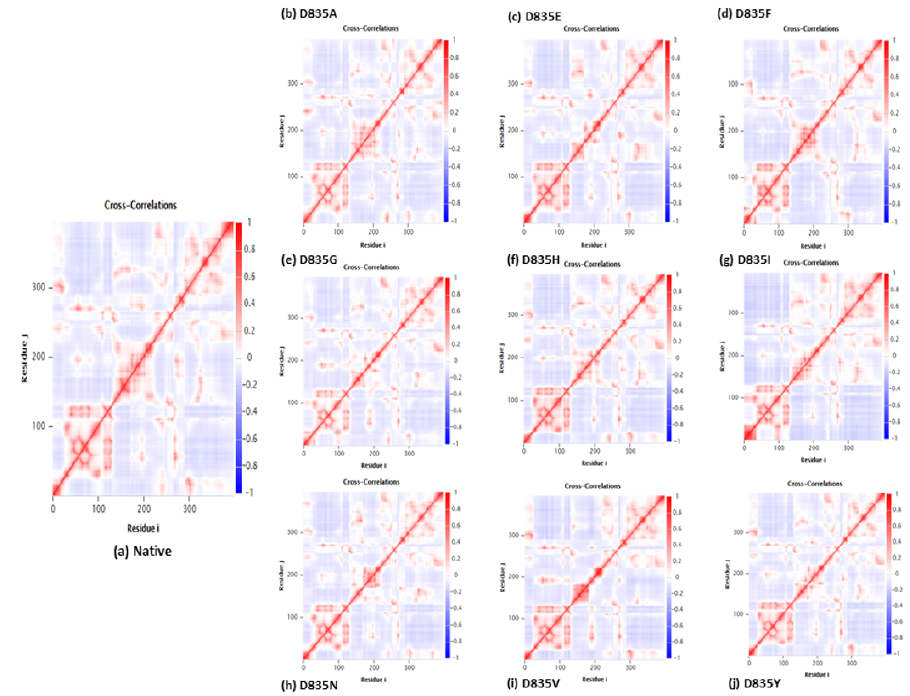
Figure 7. Native and mutant FLT3 proteins cross-correlation matrix of the fluctuations of coordinates for C α atoms around their mean positions during MD simulation; the extent of correlated motion (red color) and anti-correlated motions (blue color) are color-coded. ( a ) Native; ( b ) D835A; ( c ) D835E; (d)D835F; ( e )D835G; ( f )D835H; ( g )D835I; ( h )D835N; ( i )D835V; ( j ) D835Y.